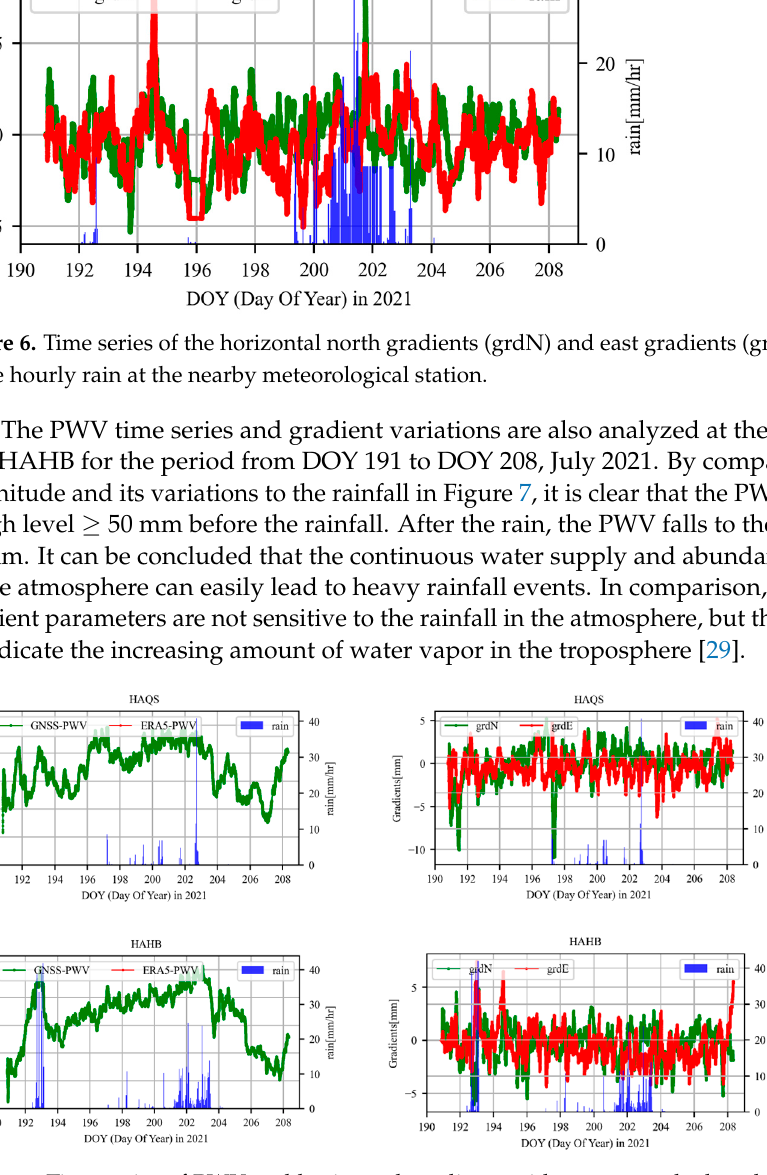
Figure 7. Time series of PWV and horizontal gradients with respect to the hourly rain for station HAQS and HAHB.